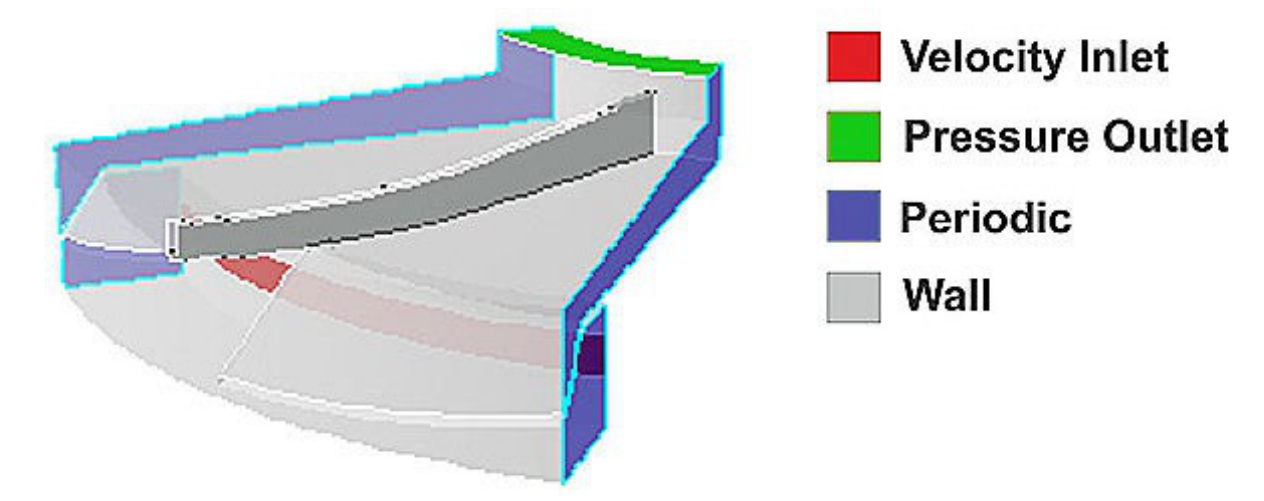
Figure 12. Boundary conditions assumed for the model. Table 6. Boundary conditions and fluid properties used in the calculations. Table 5. Algorithm for determining the velocity components (c m3 , c u3 ) on the impeller’s outlet [ 3].